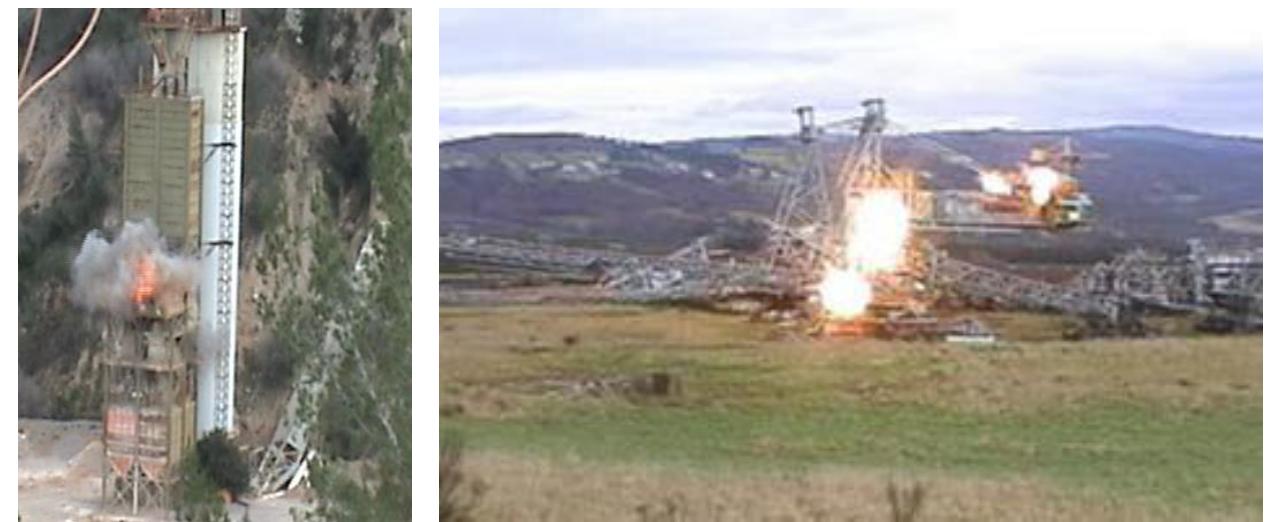
Figure 5. Demolition of metallic structures with shaped charges (( left ) metallic silo; ( right ) large mining stacker).